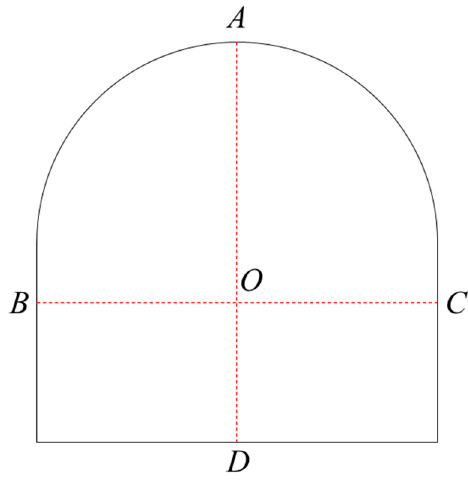
Figure 5. The monitoring points of roadway deformation.